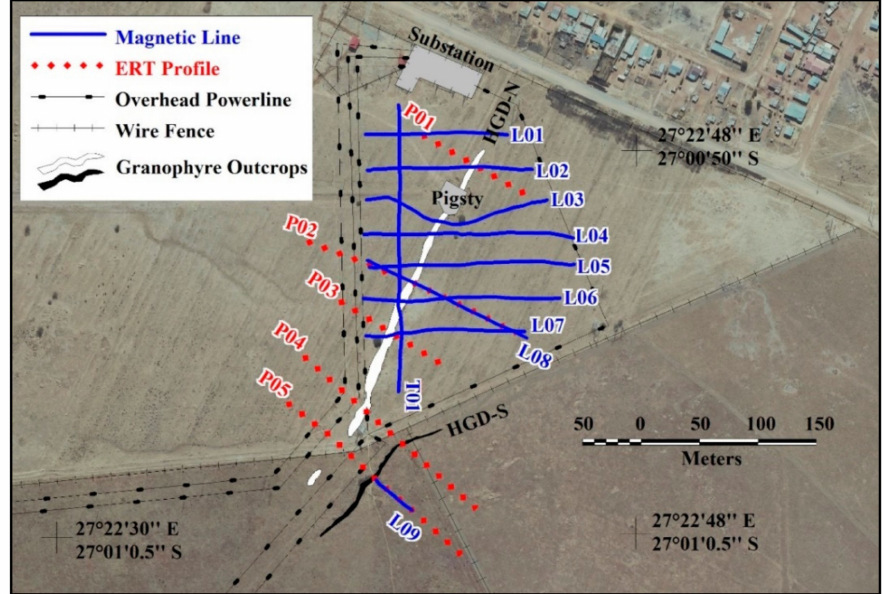
Figure 3. Positions and orientations of the magnetic lines and electrical resistivity tomography (ERT) profiles across the Holfontein Granophyre Dike (black lines) plotted on top of an aerial